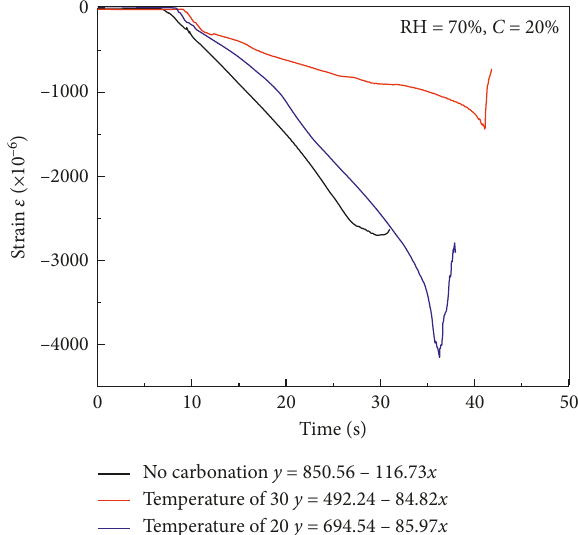
Figure 3: Strain curves of concrete surface with carbonation